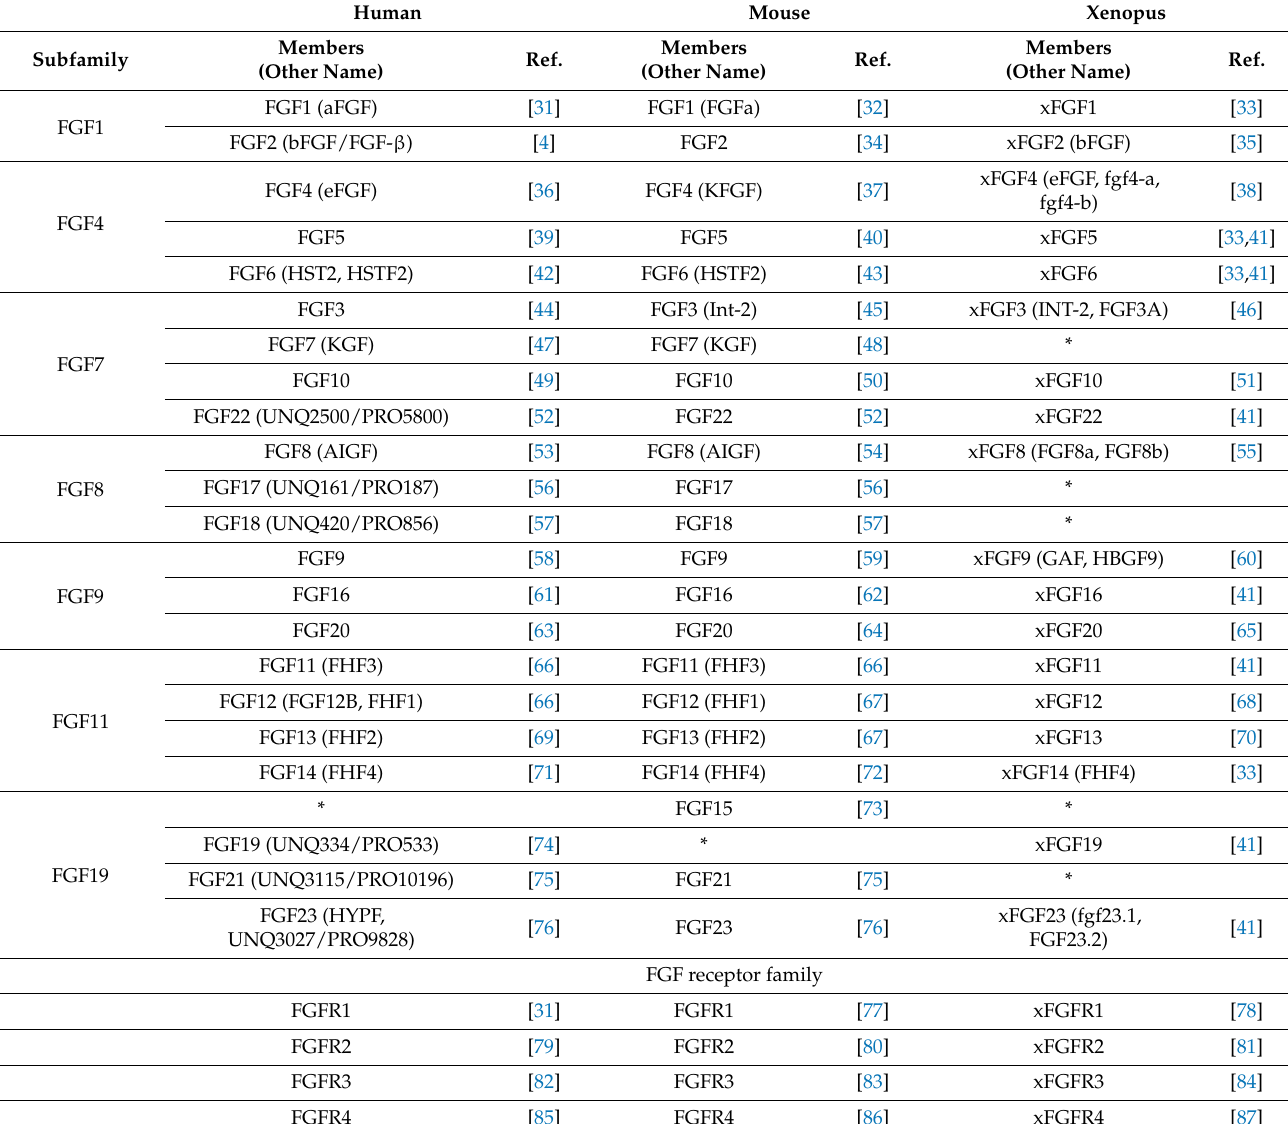
Table 1. Known FGFs and FGFRs in human, mice, and